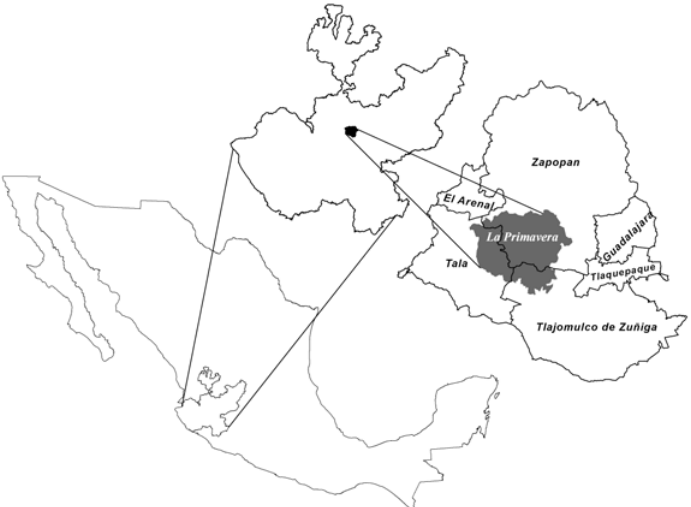
Figure 1. Study area. The location of La Primavera in México, the State of Jalisco and neighbouring